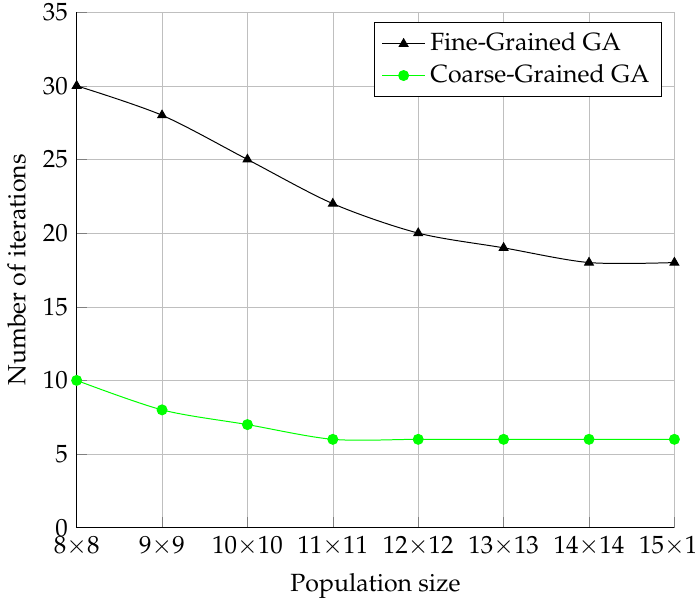
Figure 12. The comparison of Fine-Grained and Coarse-Grained model in the number of